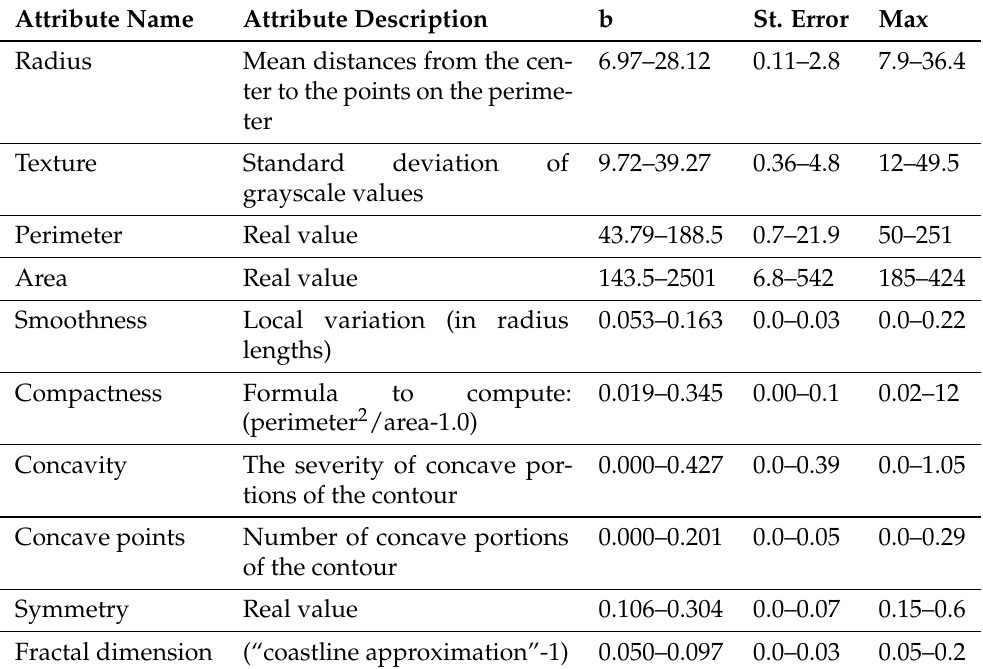
Table 2. List of attributes and their measured values after the fine-needle inspiration process.